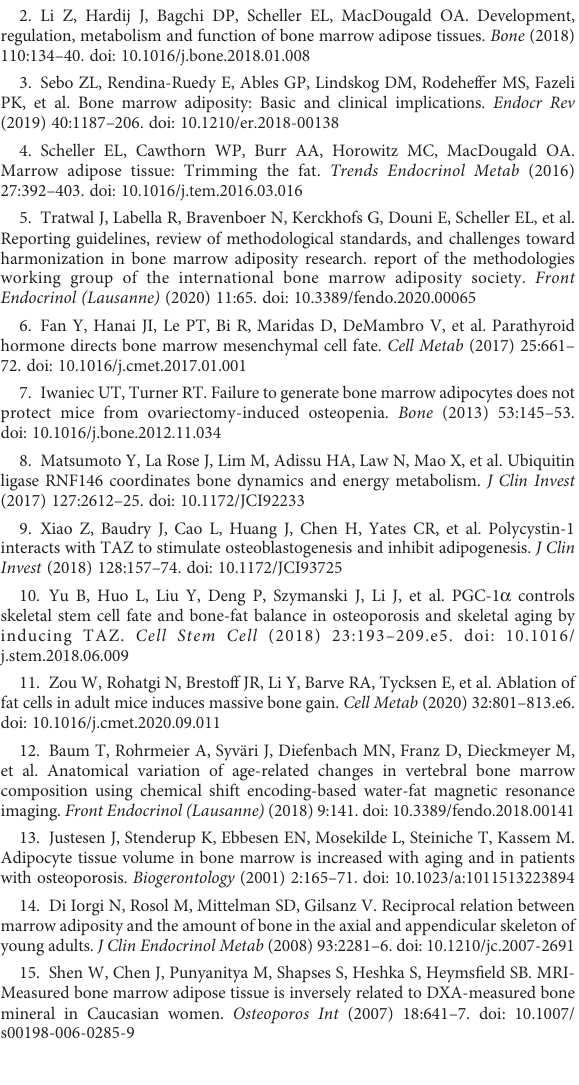
Three-D visualization, using Hf-POM-based CE-CT, of the adipocytes in the bone marrow compartment of the proximal tibia of 3-week-old PiT2 +/+ and PiT2 -/- male mice.